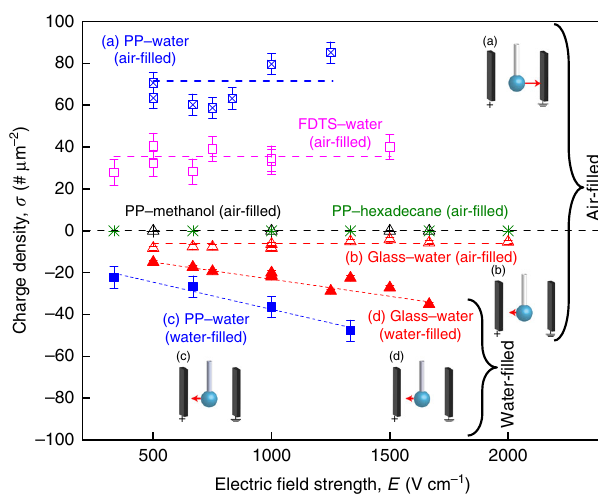
Fig. 3 Experiments inside a parallel plate capacitor. Correlations between the charge density of pendant droplets and electric fi eld strengths for water- fi lled and air- fi lled hydrophobic and hydrophilic capillaries (based on Supplementary Movies 4 – 10). Insets depict experimental con fi guration with the pendant water droplets inside the parallel plate capacitor with the positively charged plate on the left-side. Note: the red arrows present qualitatively the direction and the relative magnitudes of the de fl ections experienced by water droplets under various scenarios. When the hydrophobic capillaries were a air- fi lled (or c water- fi lled), the pendant water droplets repelled away from (or attracted towards) the positively charged plate. In the case of the hydrophilic glass capillaries, the droplets always tilted towards the positive plate of the capacitor, and we detected very low charges in b the air- fi lled case, and higher charges in d the water- fi lled case. Note: we found no de fl ection for droplets of methanol and hexadecane dispensed from air- fi lled hydrophobic capillaries in the speci fi ed range of electric fi elds. We obtained the charge density along the y -axis by normalizing the charge of the droplet obtained from the force balance [Eqs. (1 – 5)] and liquid-solid interfacial areas of the dispensed droplets. (Dotted lines have been added to guide the eye.) Error bars represent the standard deviation of duplicates. The hollow symbols represent the air- fi lled cases, and the solid symbols represent the water- fi lled cases for each interface (Color scheme: blue: PP-water; red: glass- water; magenta: FDTS-water; black: PP-Methanol; green: